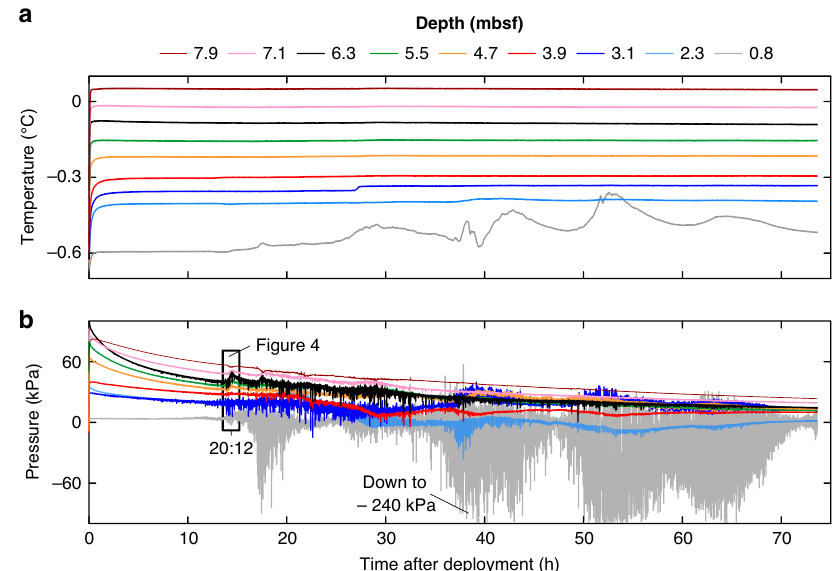
Fig. 2 Data from piezometer site PZM1. a Temperature and b pore pressure versus time. The different colors indicate the depth below the seabed. Sensor depths are between 0.8 mbsf (gray curve) and 7.9 mbsf (brown curve). Pressure axis limited to − 100 kPa, for better visualization of the majority of the data.